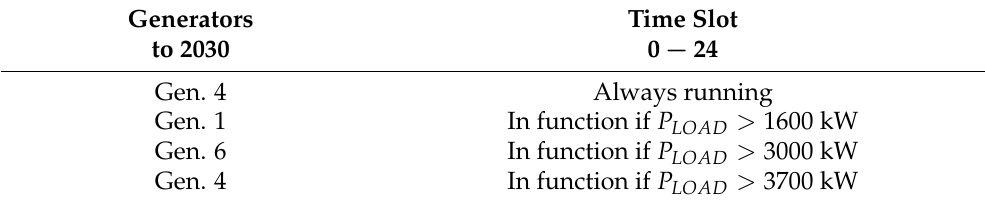
Table 21. Possible control logic of diesel groups by 2030 with RESs and BESSs: Summer.